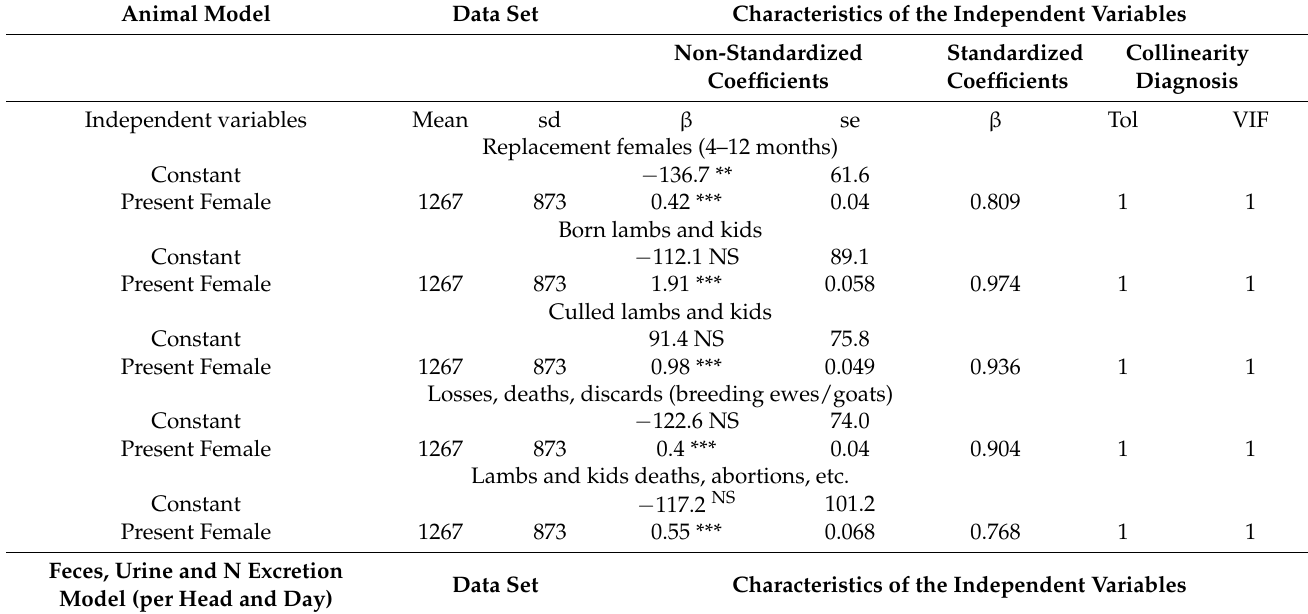
Table 4. Main characteristics of the animal model, the excreta production model (urine and fecal N), and the forage production